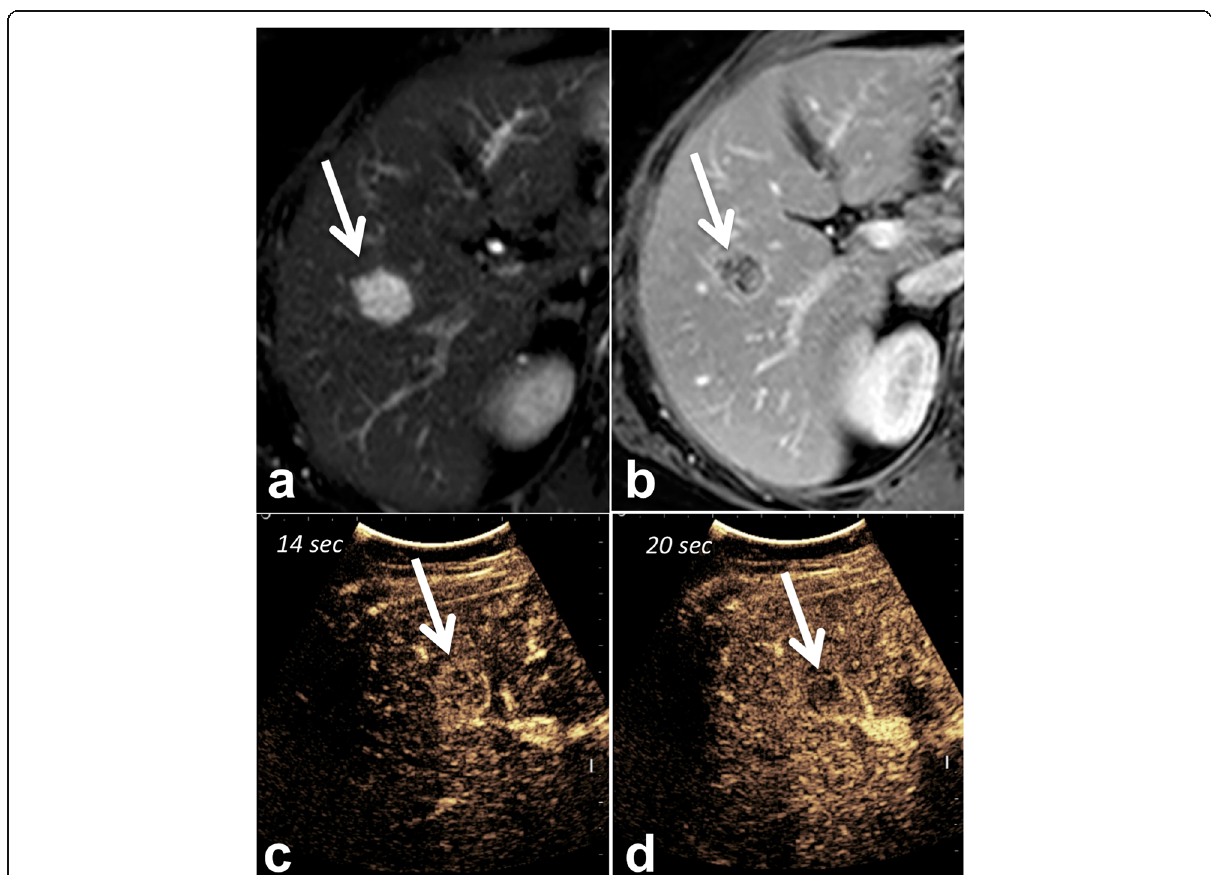
Fig. 6 Example of mucinous metastasis mimicking a hemangioma in 45-year-old male patient with colon cancer. Fat-saturated fast spin echo T2- weighted image ( a ) shows a 30 mm lesion (arrow) in segment VIII with bright signal intensity. The lesion shows peripheral rim enhancement (arrow) on extracellular gadolinium chelate-enhanced fat-saturated gradient recall echo T1-weighted image obtained during the portal venous phase ( b ). Arterial phase, contrast-enhanced ultrasound ( c ) shows rapid homogeneous enhancement at 14 s (arrow). At 20 s ( d ), the lesion shows washout (arrow), consistent with a diagnosis of liver